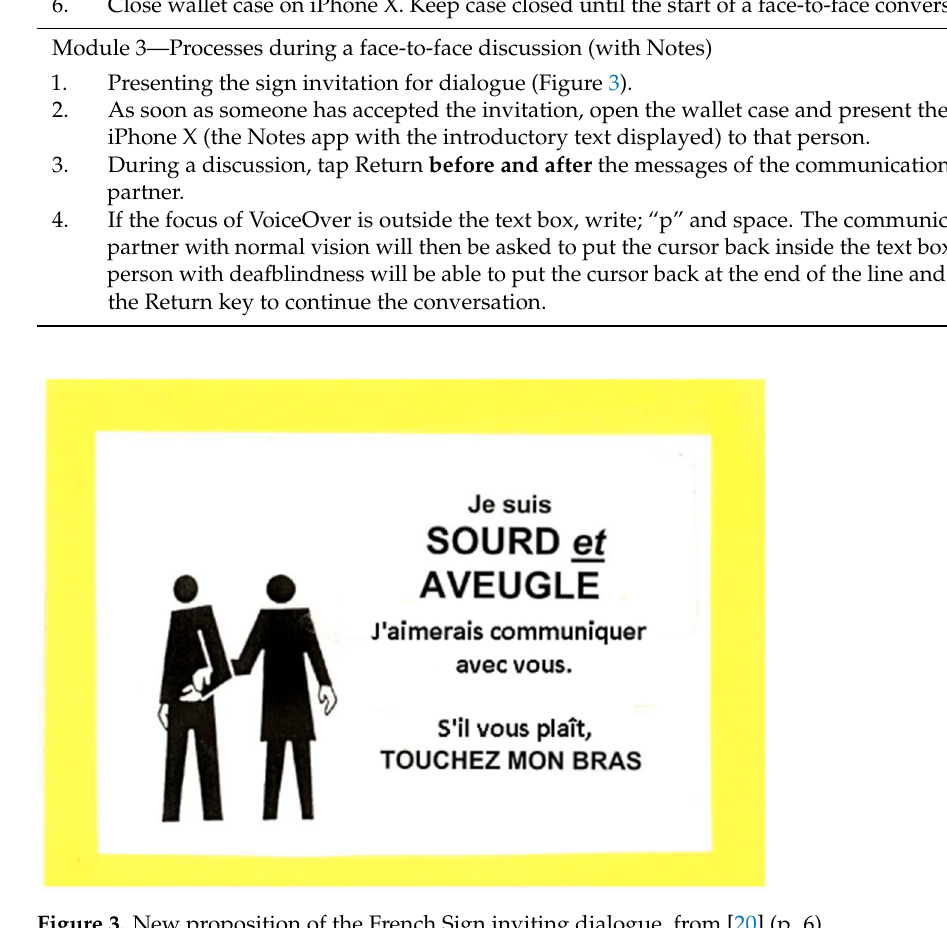
Figure 3 New proposition of the French Sign inviting dialogue, from [20] (p.